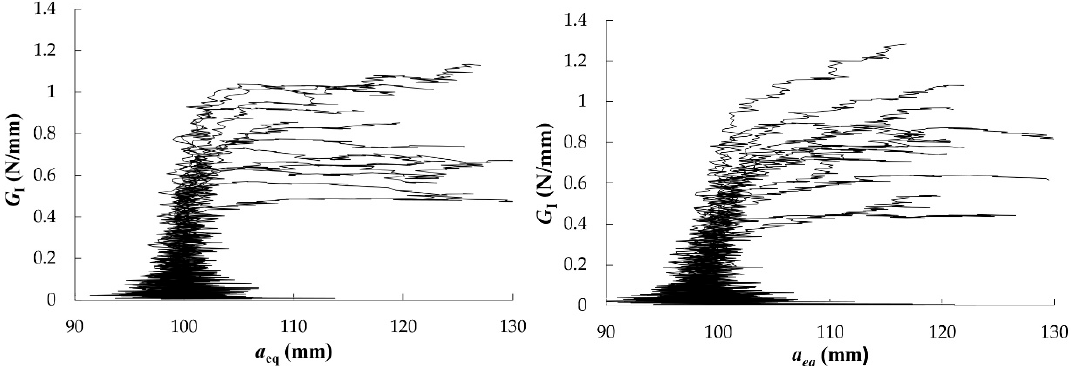
Figure 6. R- curves from DCB test in RL (left) and TL (right) propagation systems. Figure 6. R -curves from DCB test in RL ( left ) and TL ( right ) propagation Table 3. Fracture energy obtained from DCB specimens oriented in RL by means of Compliance- Based Beam Method (CBBM).